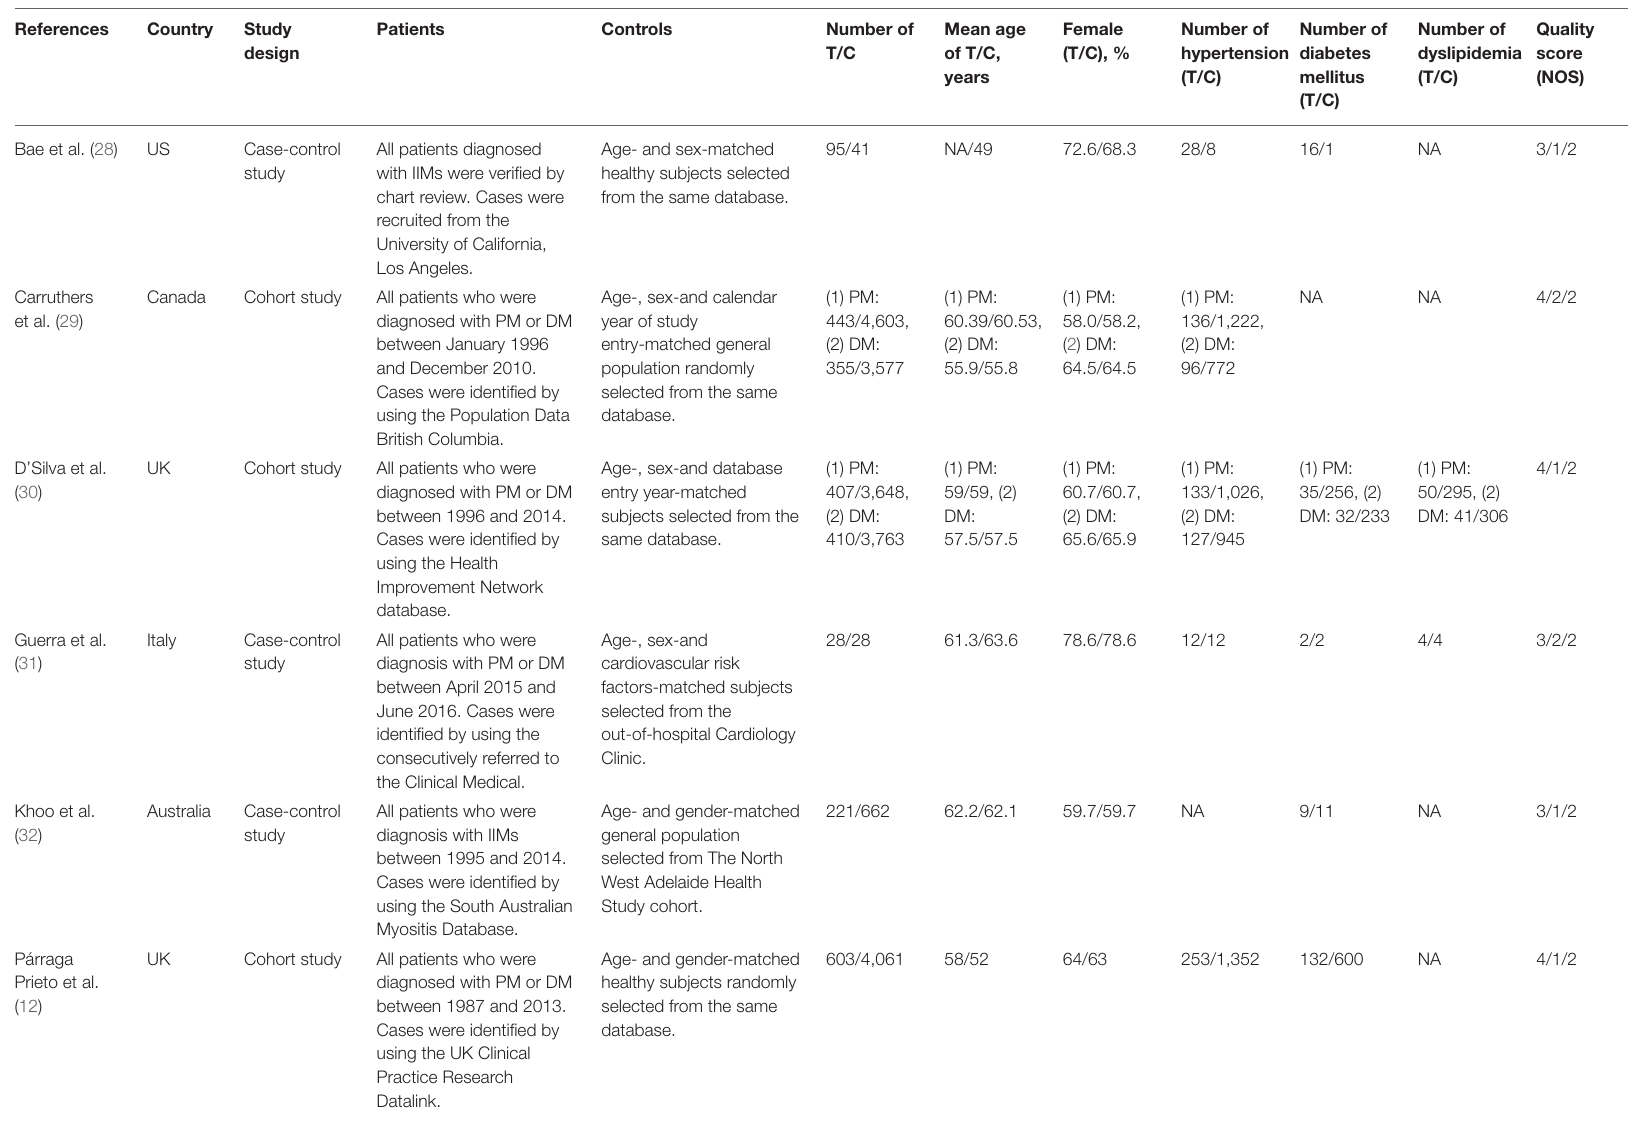
TABLE 2 | Main characteristics of the included studies on cardiovascular risk factors in this